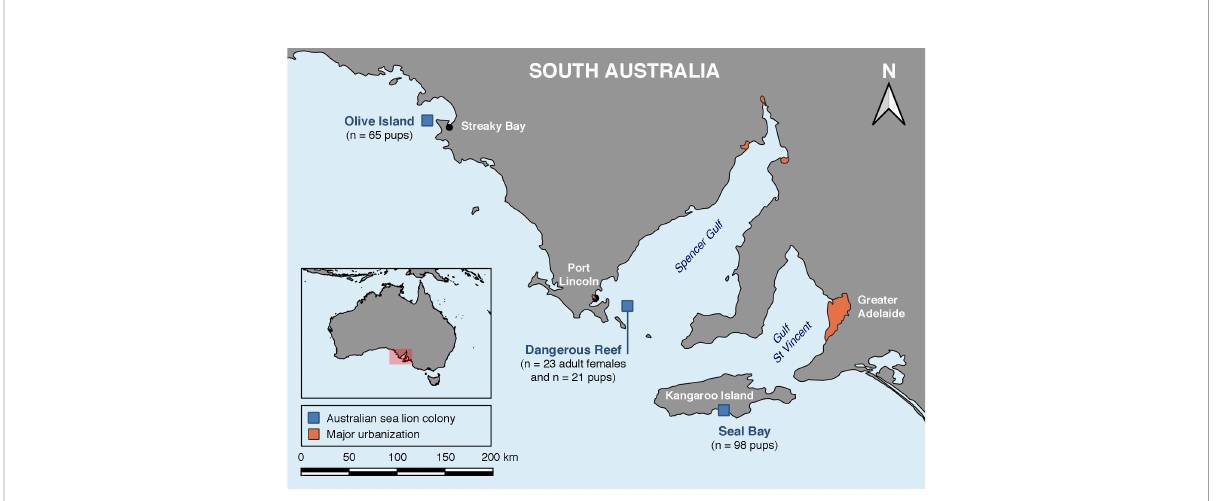
FIGURE 2 Location of the three Australian sea lion ( Neophoca cinerea ) colonies sampled for the serological survey of T. gondii antibody presence in adult females and